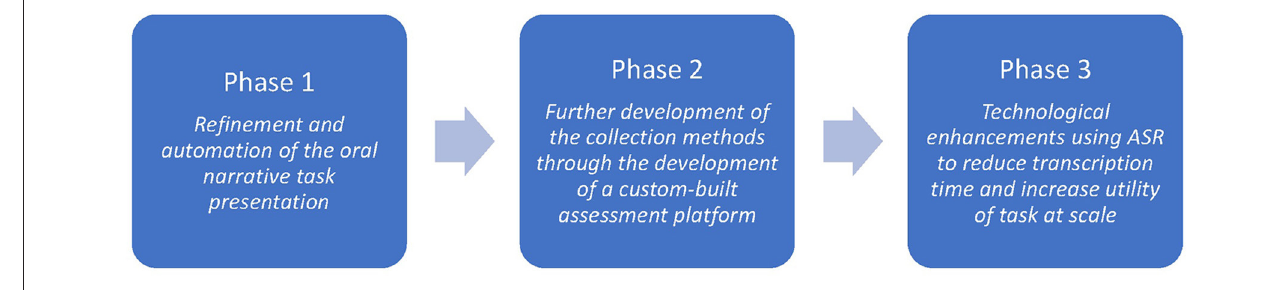
FIGURE 1 | Phases of development of the BSLA oral narrative task.